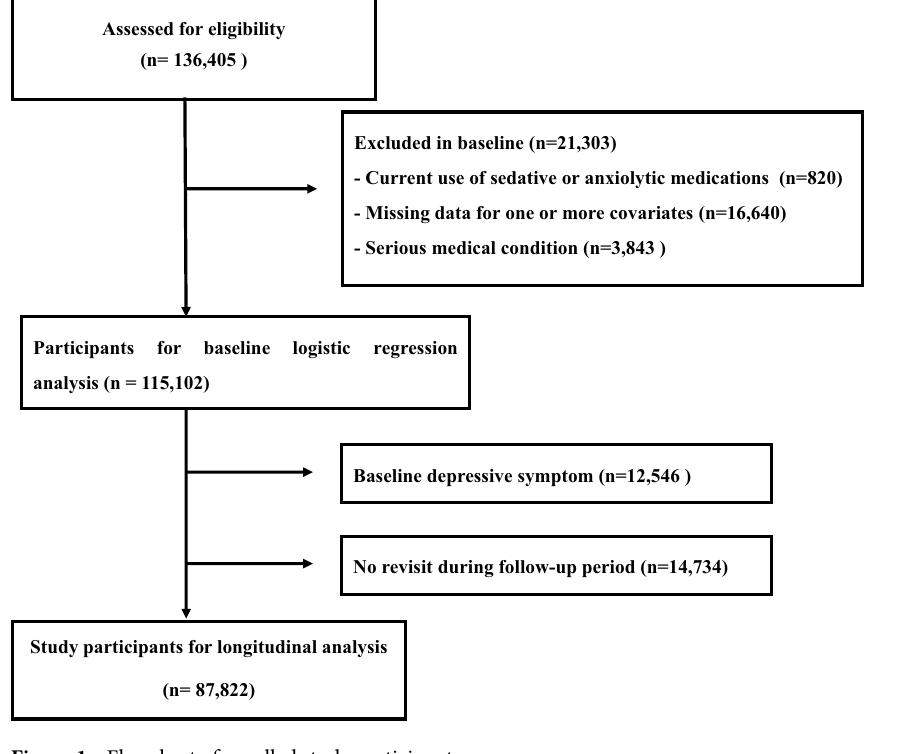
Figure 1. Flowchart of enrolled study